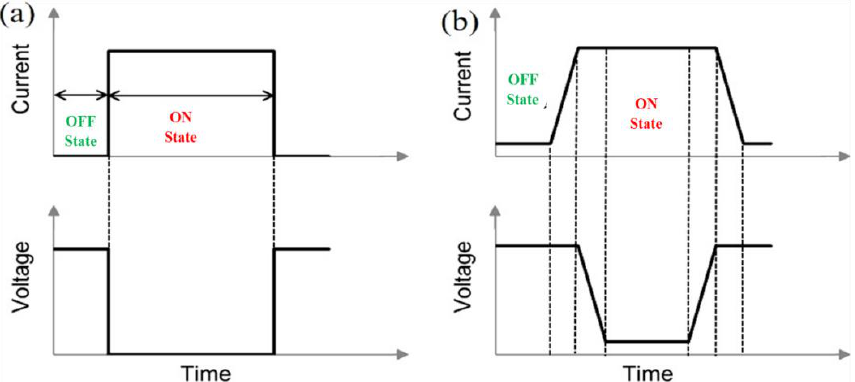
Figure 3. The current and voltage across ( a ) an ideal power switching device and ( b ) a power switching